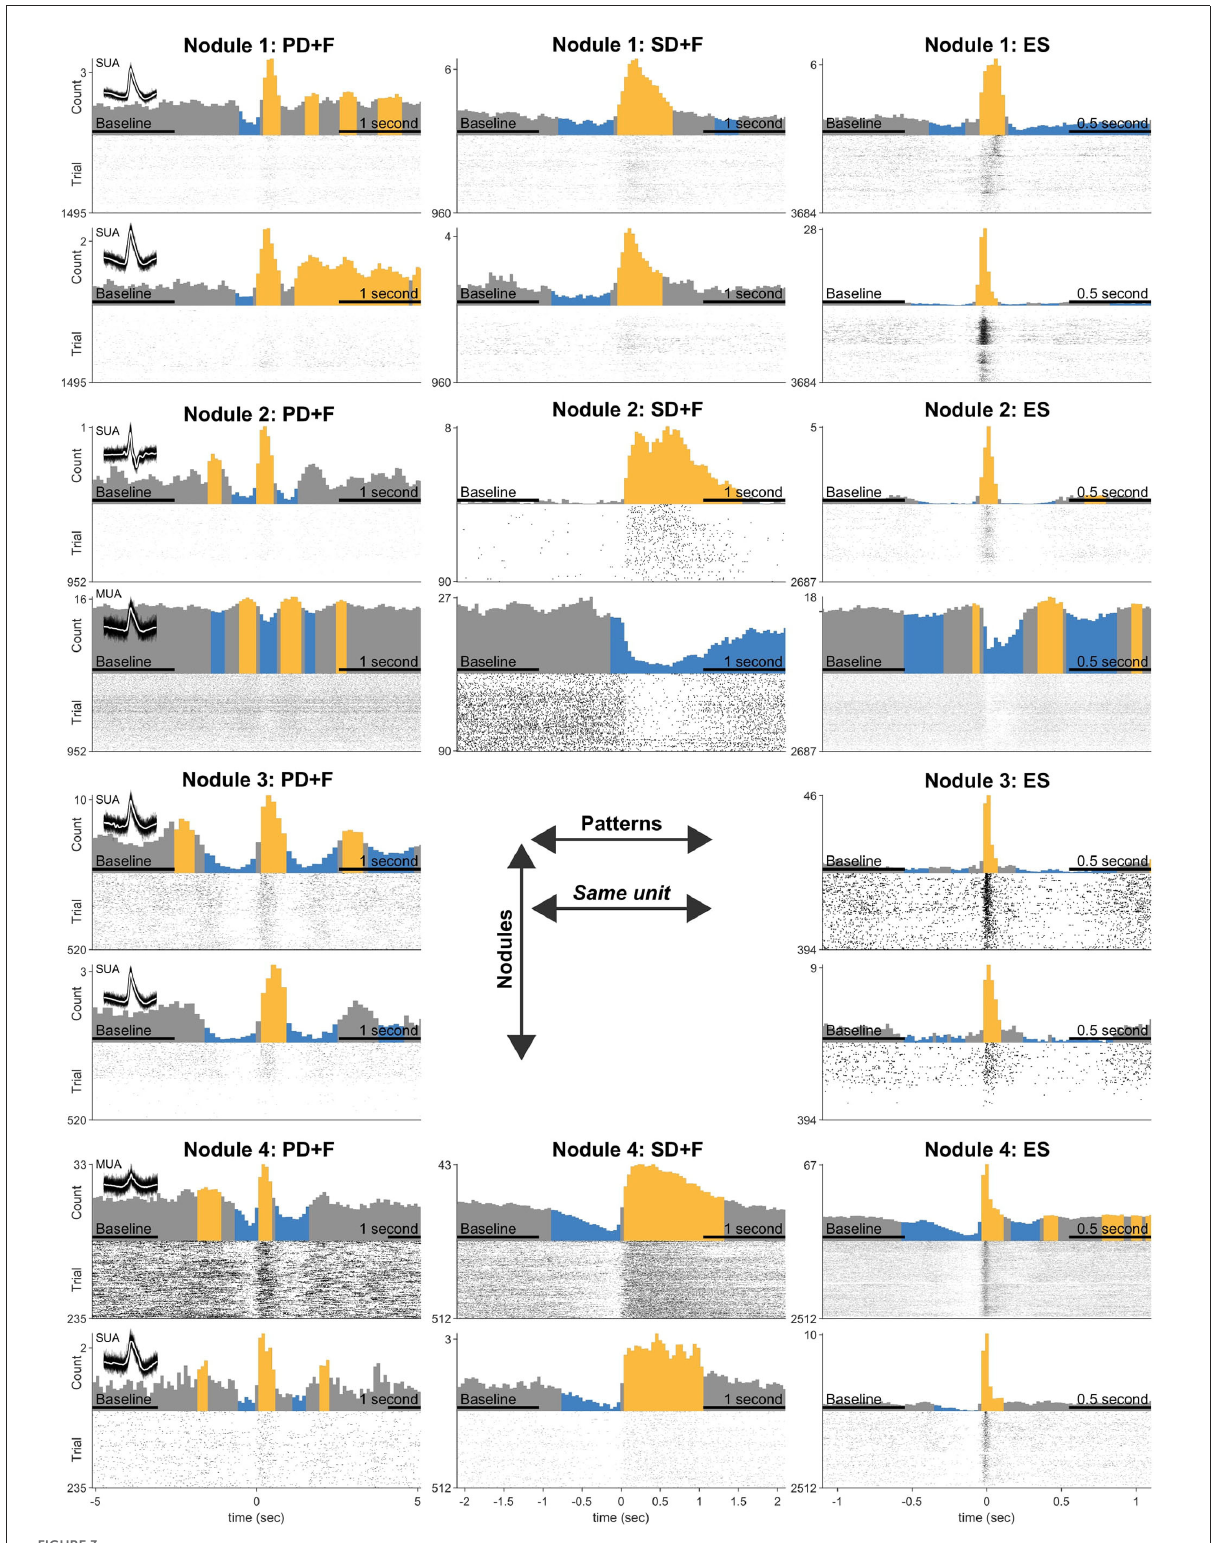
FIGURE3 Statistical analysis of firing rate responses during the IPs. Each row represents the firing responses of one unit, shown with a firing rate histogram centered on the onset of IP, above the respective raster plot. The yellow color indicates significant increases and the blue color decreases compared with the average firing rate during baseline (indicated in the x-axis). Two units are shown for every nodule (three patients). Panel titles indicate an interictal pattern. Note that each unit (row) shows significant modulation in every pattern. Inset shows 100 examples of action potential spikes, overlaid with their average spike waveform in